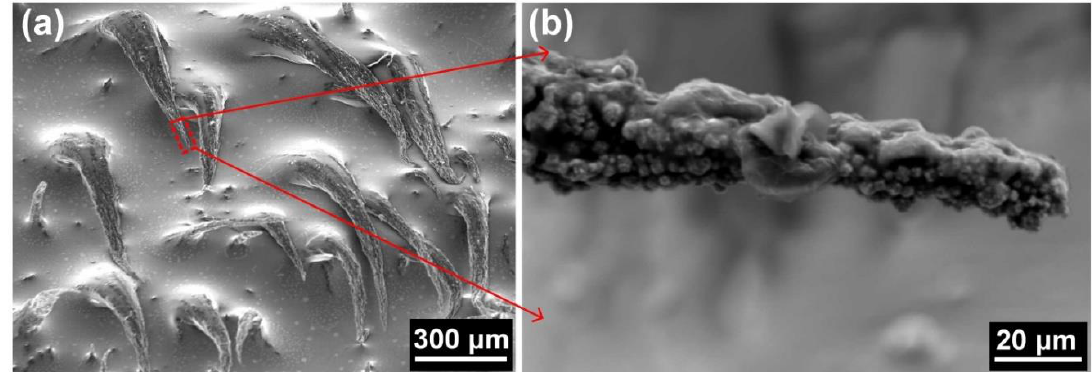
Figure 9. Typical configurations of flattened Shape Memory Polymer/Nickel (SMP/Ni) chain array with 2% nickel particles. ( a ) Morphology of flattened pillars; ( b ) Zoomed-in view of (a).